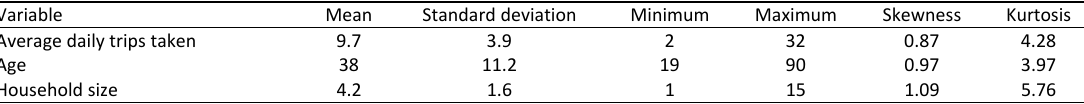
Table 3: Summary Statistics of the Selected Variables (in levels)